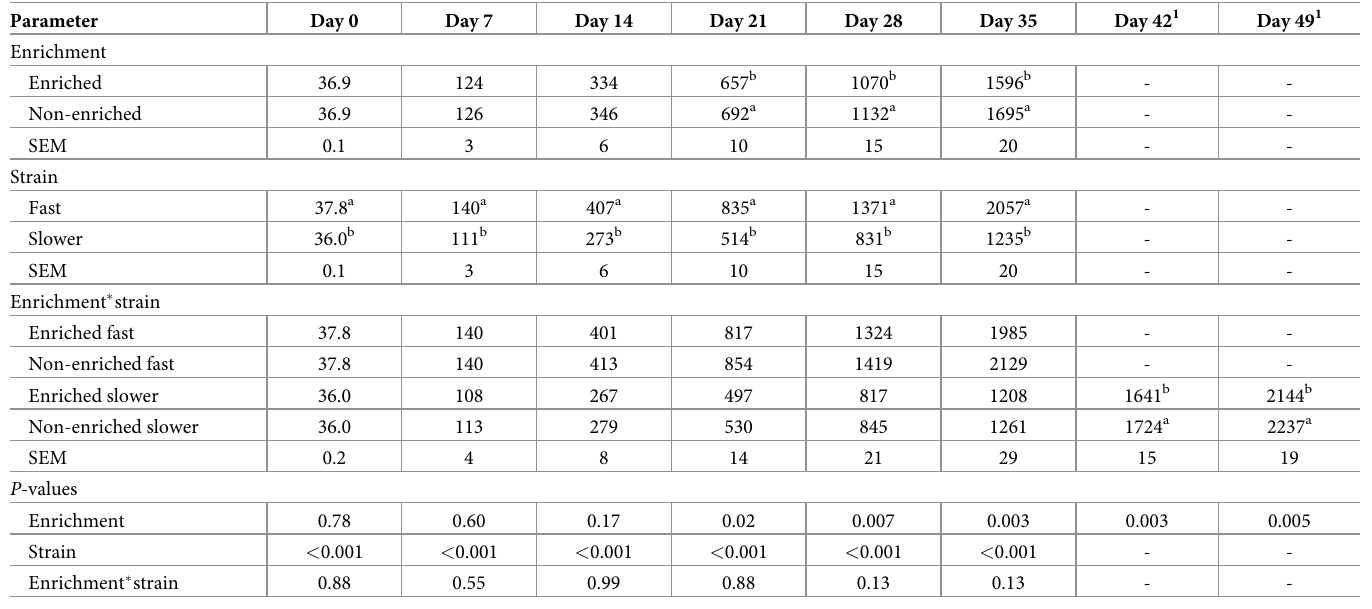
Table 1. Effects of pen enrichment (enriched or non-enriched), broiler strain (fast-growing ross 308 or slower-growing Hubbard JA 757) and their interaction on body weight (g) of male broiler chickens at different ages (n = 7 pens per treatment, LSmeans ± SEM).